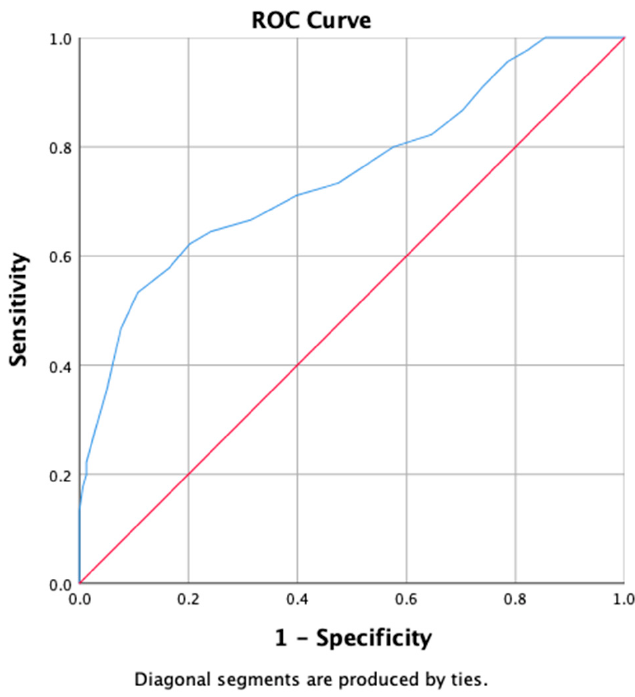
Figure 1. ROC curve sensitivity and specificity of SAVE-9 Malay version compared with GAD-7 Malay version.